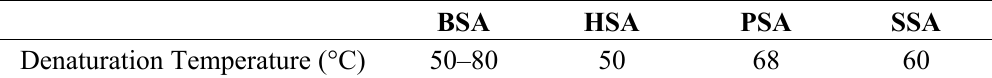
Table 3. Denaturation temperatures of different albumins.